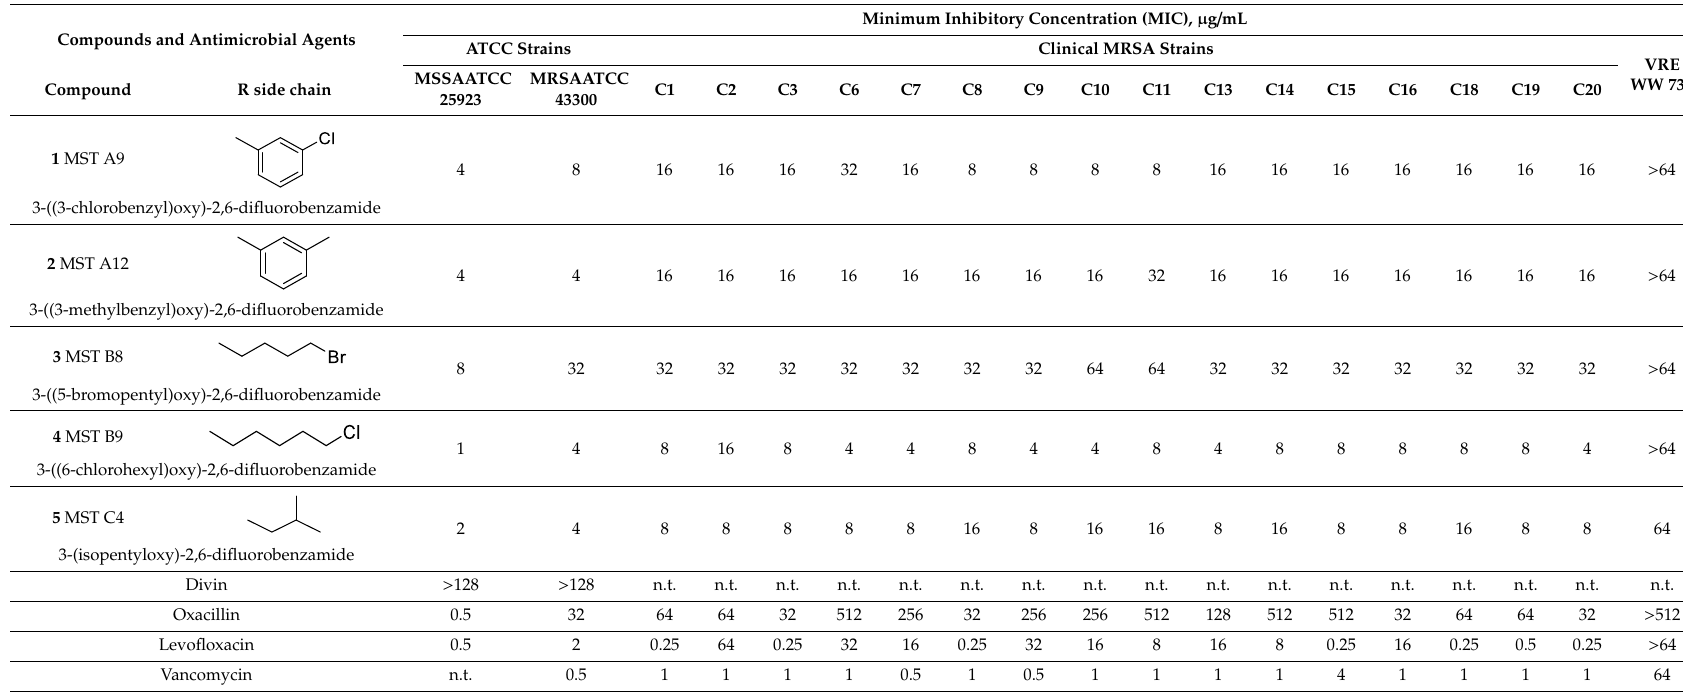
Minimum Inhibitory Concentration (MIC), µg/mL Compounds and Antimicrobial Agents ATCC Strains Clinical MRSA Strains